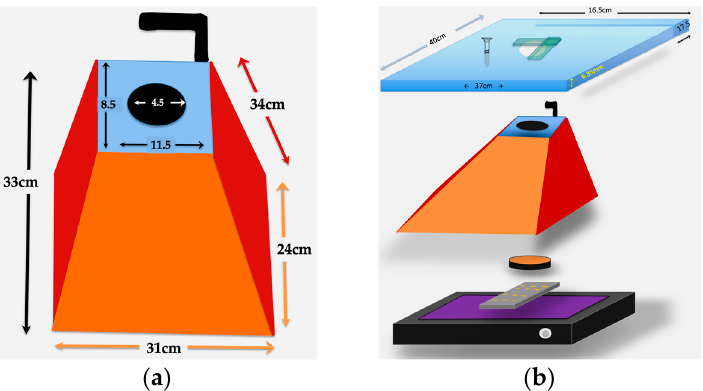
Figure 1. Dimensions and assembly of hood and camera mount. ( a ) Dimensions of the repurposed Fotodyne photography hood are provided for those who choose to build one. This version, 33 cm in height, completely covers the UV light source, has a metal camera mount fastened to the back (black L-shape), and has a 4.5 cm diameter hole for a lens mount. ( b ) Order and assembly of parts for the phone/iPad stand. A grooved line ~4 mm wide was cut into the quarter-inch acrylic sheet at the indicated position, ending ~1.5 cm from the lens holder. This was done to accommodate the camera mount, see Figure 2. The acrylic sheet was fastened into the top of the photography hood using 4 screws. A barrier filter (590 nm for ethidium bromide staining) is placed underneath the hole, at the top of the photography hood, covering the hole. This was taped in place for easier removal when photography of protein gels is performed or when shifting bandpass filters for SYBR-stained gels A layer of plastic wrap can be used to protect the surface of the UV transilluminator during imaging of wet gels, although care must be taken that the brand of plastic does not absorb